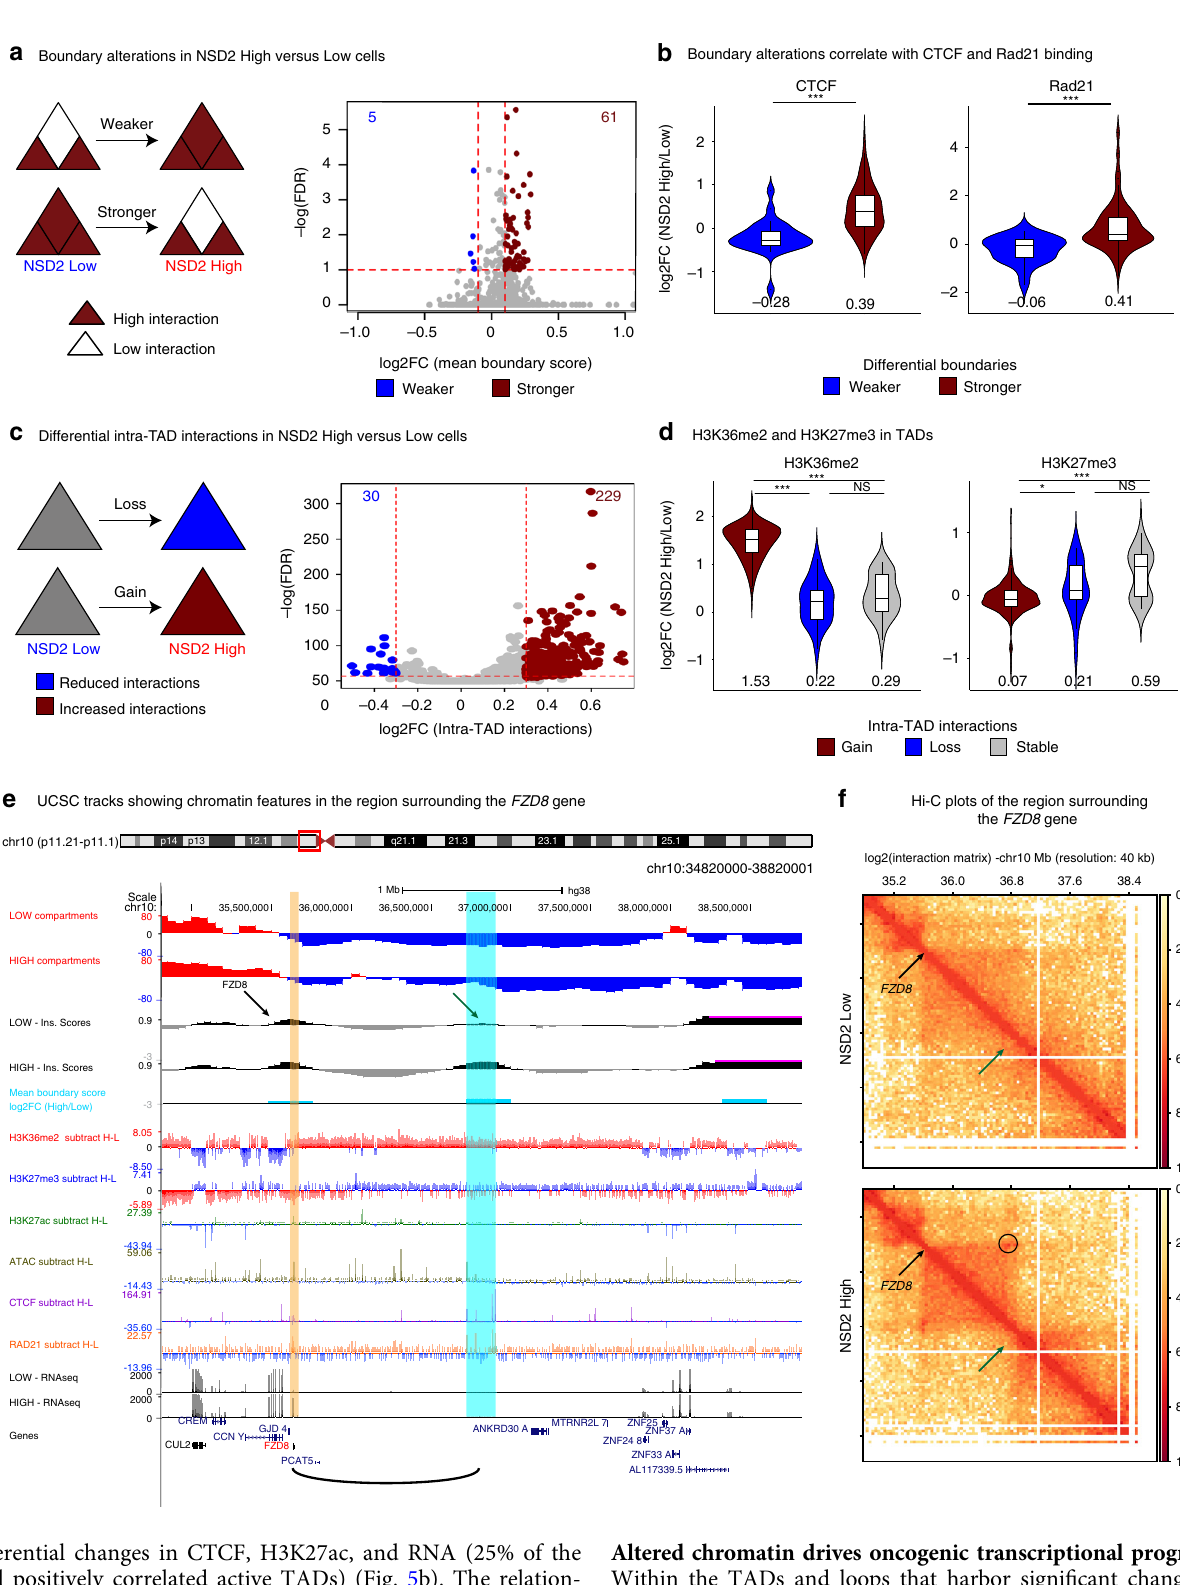
differential changes in CTCF, H3K27ac, and RNA (25% of the total positively correlated active TADs) (Fig. 5b). The relation- ship between signi fi cant changes in gene expression and concordant versus discordant alterations in H3K27ac and CTCF in TADs and CTCF-mediated loops is shown in Supplementary Fig. 9c. These analyses indicate that the vast majority of changes in CTCF, H3K27ac, and transcriptional output are positively correlated.